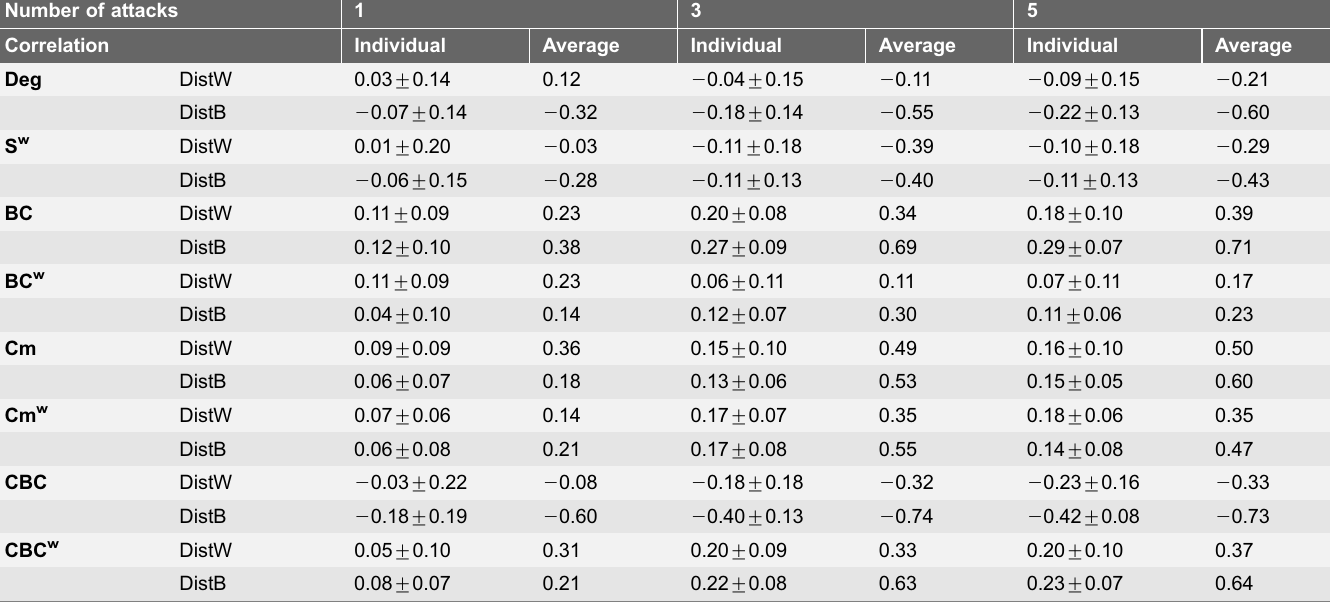
For binary distance the Spearman’s correlation coefficient is reported (rows DistB), while for weighted distance the Pearson’s correlation coefficient is given (rows DistW). Mean and standard deviations of individual correlations are reported (Individual) as well as the correlation coefficients between the average change and average distance from lesions